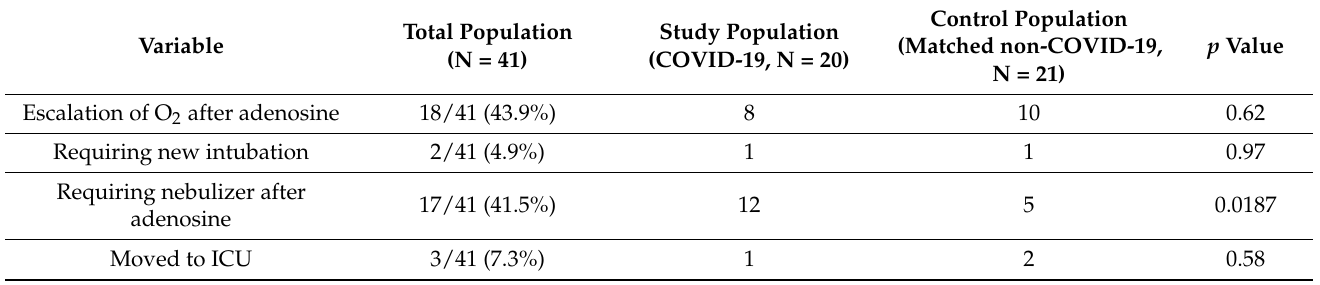
Table 4. Comparison of individual escalation parameters between the study and control